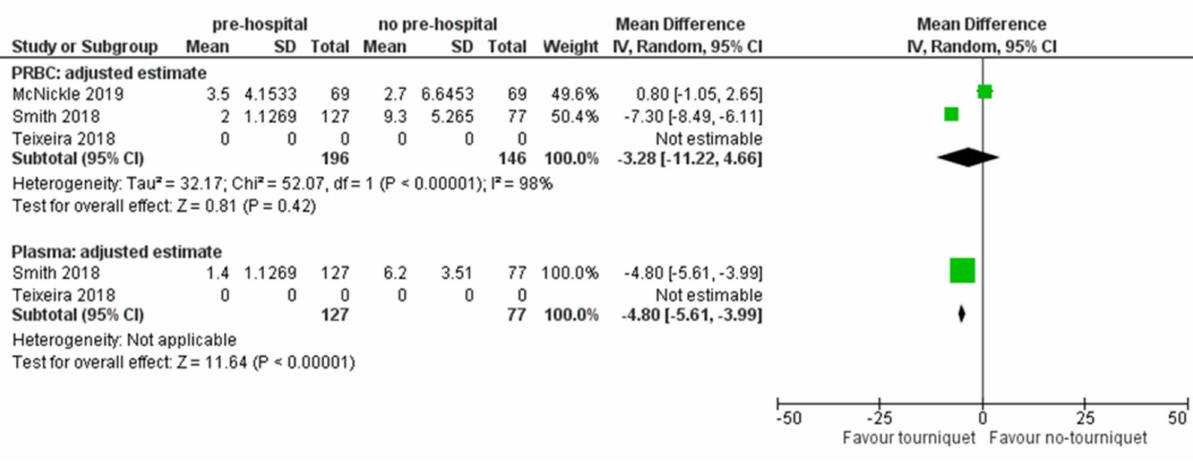
Figure 3. Adjusted odds ratios for mortality due to haemorrhage of PH-T vs. NO